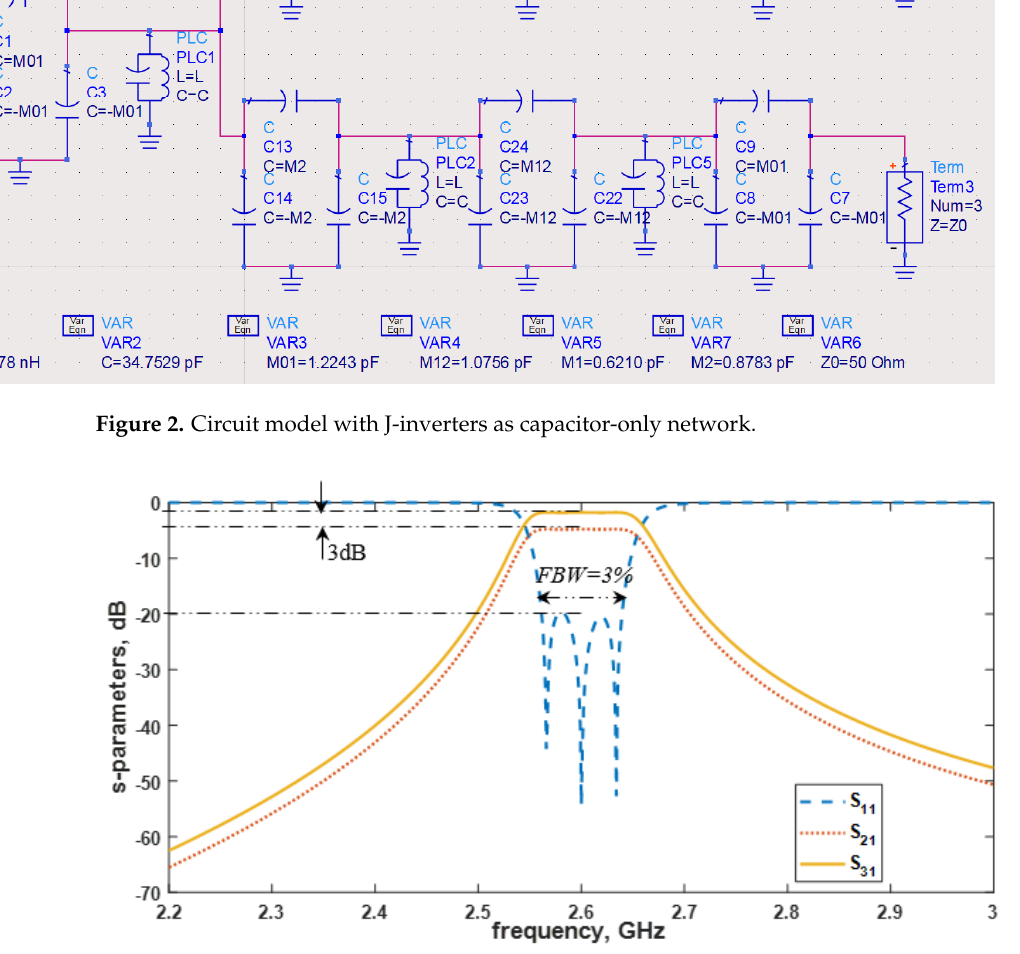
Figure 3. Results of the unbalanced filtering power splitter circuit model.